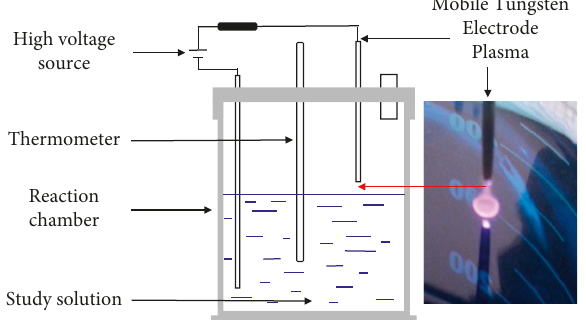
Figure 1: Scheme of the experimental device used for the treatment of the solutions by nonthermal